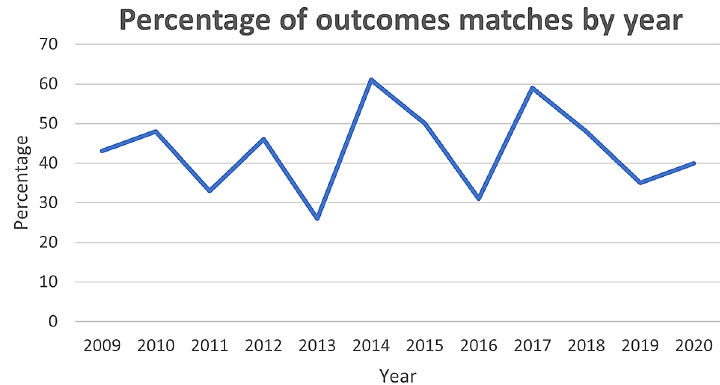
Figure 2. Percentage of outcome matches by year.